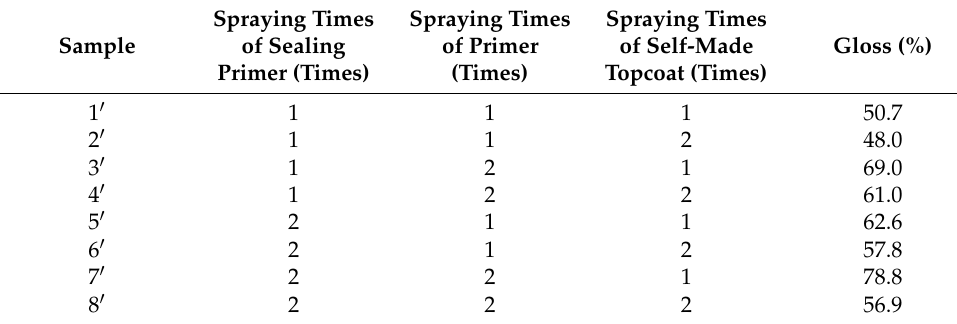
Table 9. Films’ gloss under different spraying